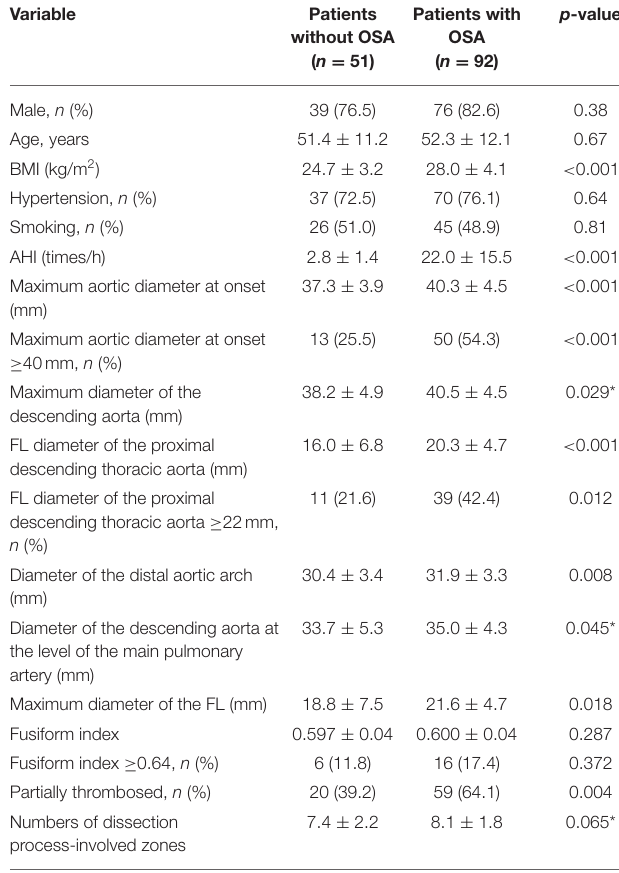
TABLE 1 | Baseline characteristics of the patients. TABLE 2 | Characteristics of the TBAD patients with and without